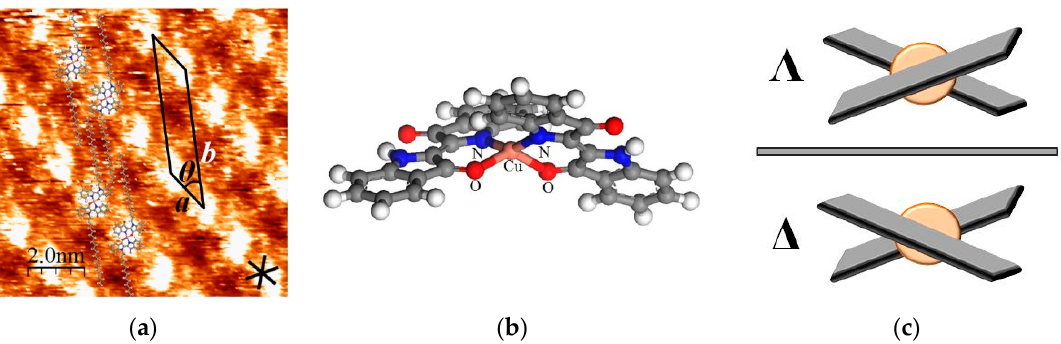
Figure 6. ( a ) STM image and structural model of type 2 structure formed by [Cu(C20IND) 2 ]. Image area: 10 × 10 nm 2 ; V set = 1.41 V, I set = 697 pA; unit cell parameters: a = 1.7 nm, b = 4.8 nm, θ = 34°; ( b ) twisted coordination model of [Cu(IND) 2 ]; ( c ) 3D chiral model of [Cu(IND) 2 ].